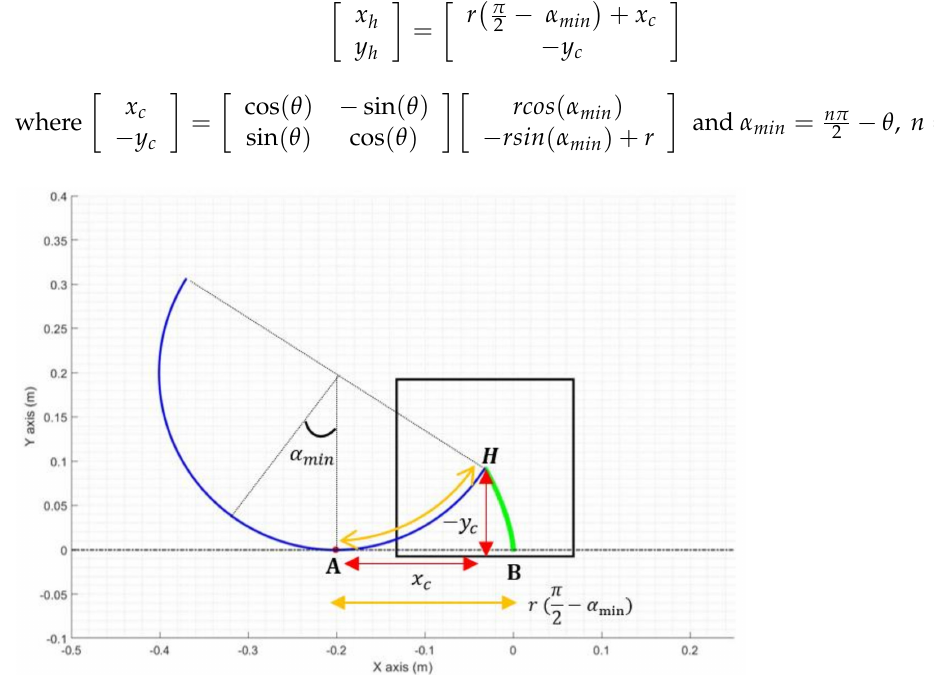
Figure 6. System schematics when leg rotated 4 π